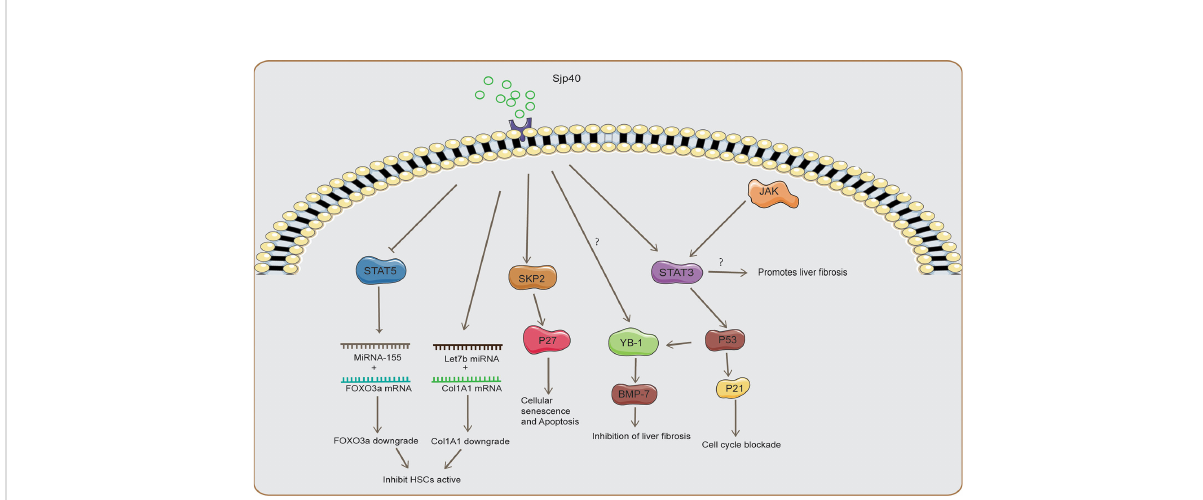
FIGURE 1 The mechanism of SSLF inhibition by Sjp40. Sjp40 inhibited STAT5 activity to promote MicroRNA-155 expression, which down-regulated FOXO3a to inhibit the proliferation and activation of HSCs and upregulation of Let-7b in HSCs to inhibit type I collagen expression. Sjp40 promotes cellular senescence in HSCs by upregulating the SKP2/P27 signaling pathway. Sjp40 promotes Y-Box protein-1 (YB1) expression to initiate BMP-7 transcription. Sjp40 promoted the P53/P21 signaling to inhibit cell proliferation, and P53 promotes nuclear translocation of YB-1. Inhibition of JAK2/STAT3 signaling could inhibit